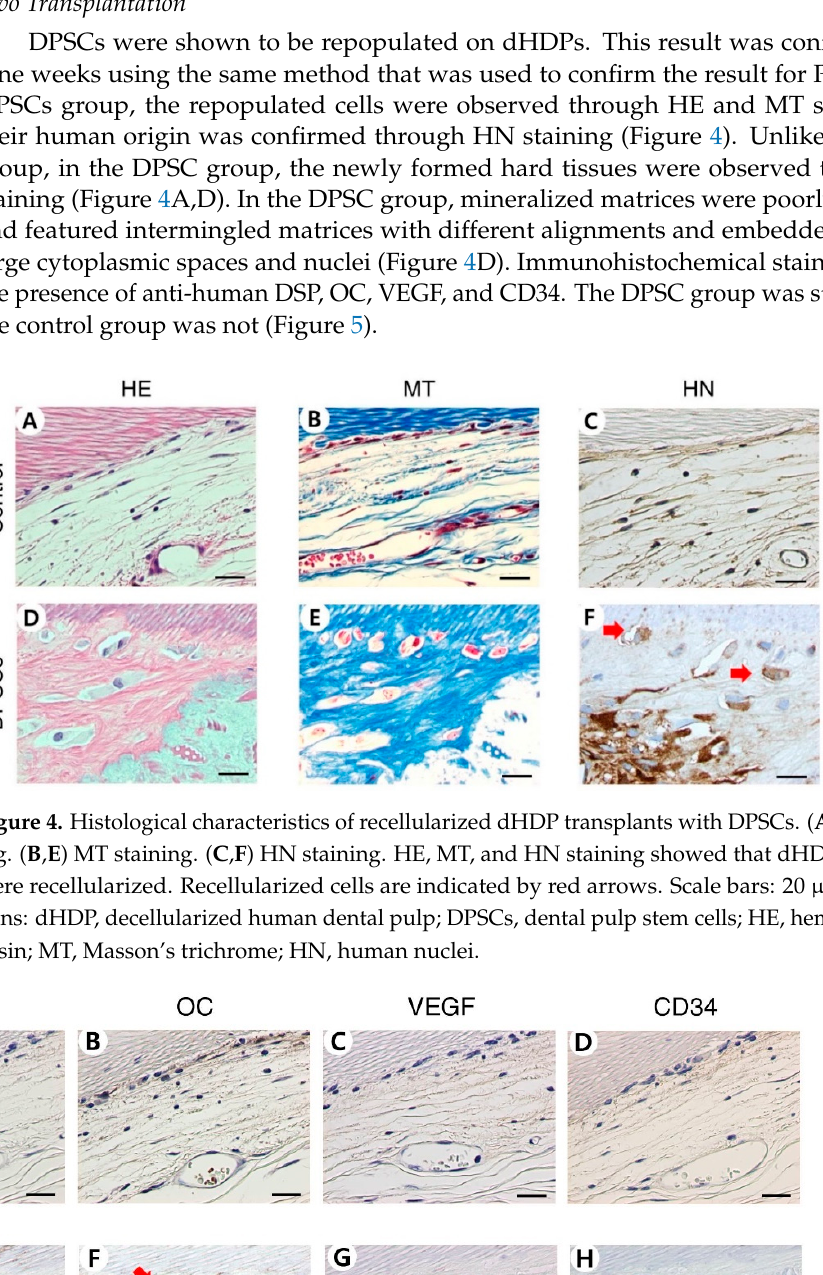
Figure 3. Evaluation of gene expression level by relative fold changes for genes encoding CP23 , Col XII , POSTN , OC , ALP , and Col I in dHPDL transplants. The expression levels of CP23 , Col XII , OC , ALP , and Col I differed significantly between the two groups (* p < 0.05). The expression of POSTN did not differ significantly between the two groups ( p > 0.05). Abbreviations: C, control group; P, PDLSC group, CP23 , cementum-derived protein 23; Col XII , collagen type XII; POSTN , periostin; OC , osteocalcin; ALP , alkaline phosphatase; Col I , collagen type I; dHPDL, decellularized human periodontal ligament.